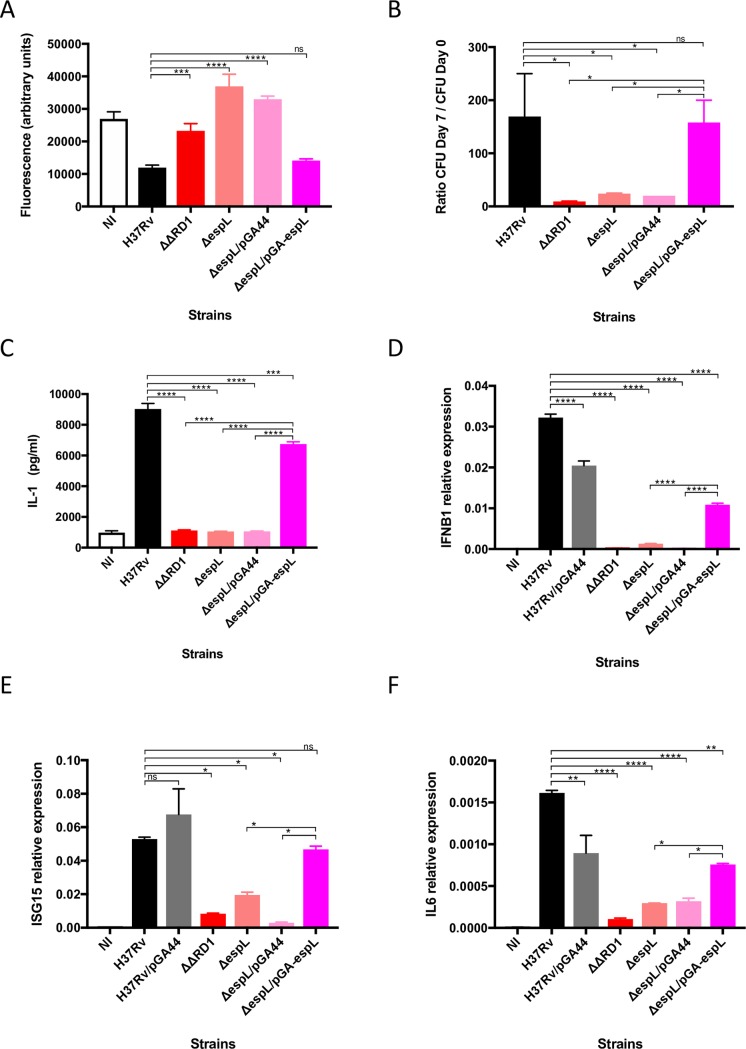
Ex vivo phenotype of ΔespL mutant.A) Virulence of ΔespL mutant compared to H37Rv and complemented strain in the THP-1 infection model. ΔΔRD1 carries a deletion of the extended ESX-1 locus. THP-1 cells were infected at multiplicity of infection (MOI) of 5. Fluorescence measurements directly correlate with THP-1 viability. Data were expressed as the mean and standard deviation (SD) of four independent replicates. B) Colony forming unit (CFU) evaluation of intracellular bacteria upon THP-1 infection. THP-1 cells were infected at multiplicity of infection (MOI) of 20:1 (cells:bacteria). Data were expressed as the mean and SD of two independent replicates. C), D), E) and F) Cytokine expression levels measured upon THP-1 infection with different bacterial strains. IL-1β was detected by ELISA assays. IFNB, ISG15 and IL6 were quantified by qRT-PCR. Data were expressed as the mean and SD of two independent replicates. NI: not infected control. *, p < 0.05. **, p < 0.005. ***, p < 0.0005. ****, p < 0.0001. ns, not significant in one-way ANOVA followed by Tukey’s multiple comparison test.